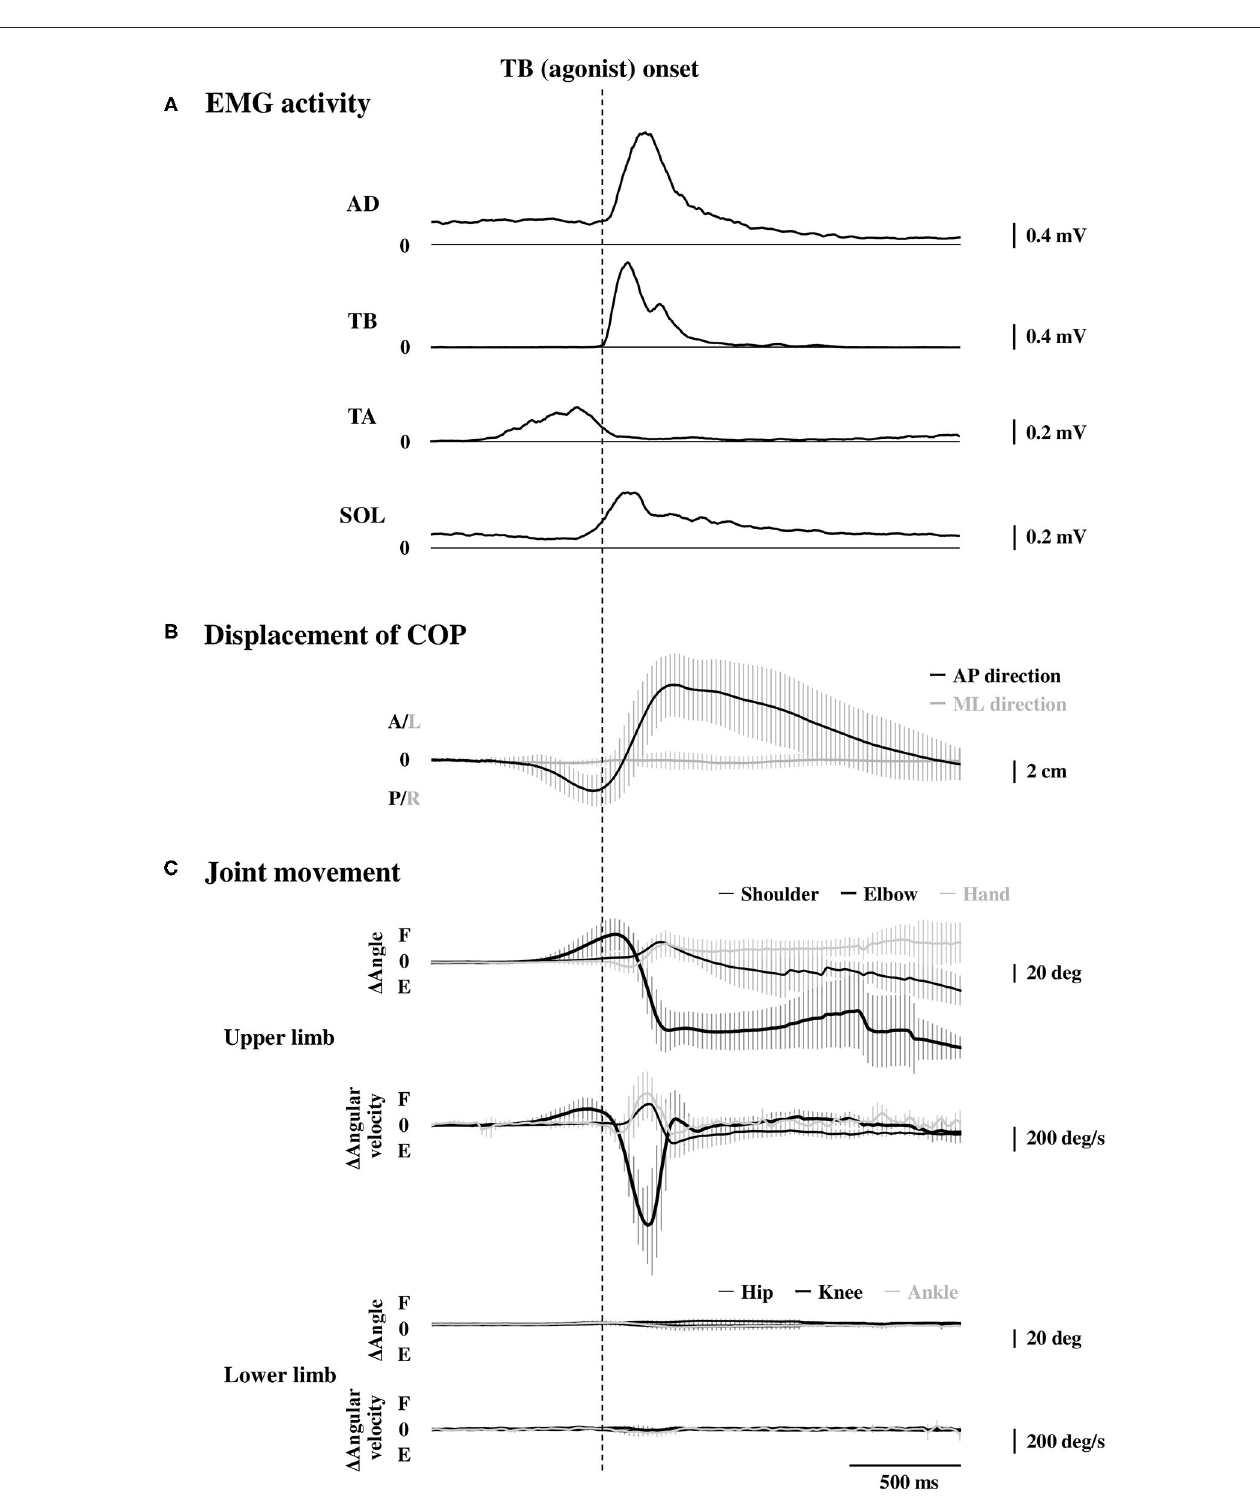
FIGURE 2 | Rectified and averaged EMG activities of the AD, TB, TA, and SOL muscles ( A , n = 15), displacement of the COP ( B , n = 15), and the joint movements in the upper and lower limbs ( C , n = 9) in the time course. All the data were aligned to the EMG onset of the TB muscle. Error bar indicates the SD. EMG, electromyography; AD, anterior deltoid; TB, triceps brachii; TA, tibialis anterior; SOL, soleus; COP, the center of pressure.